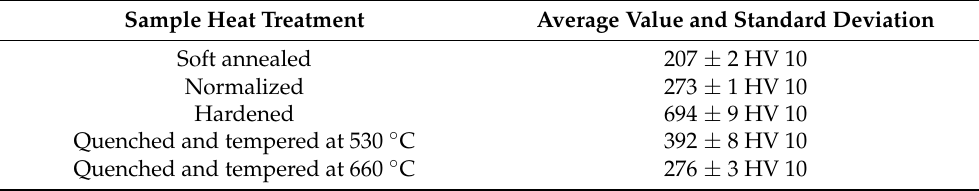
Table 5. Measured Vickers hardness values of the analyzed samples after heat treatment.